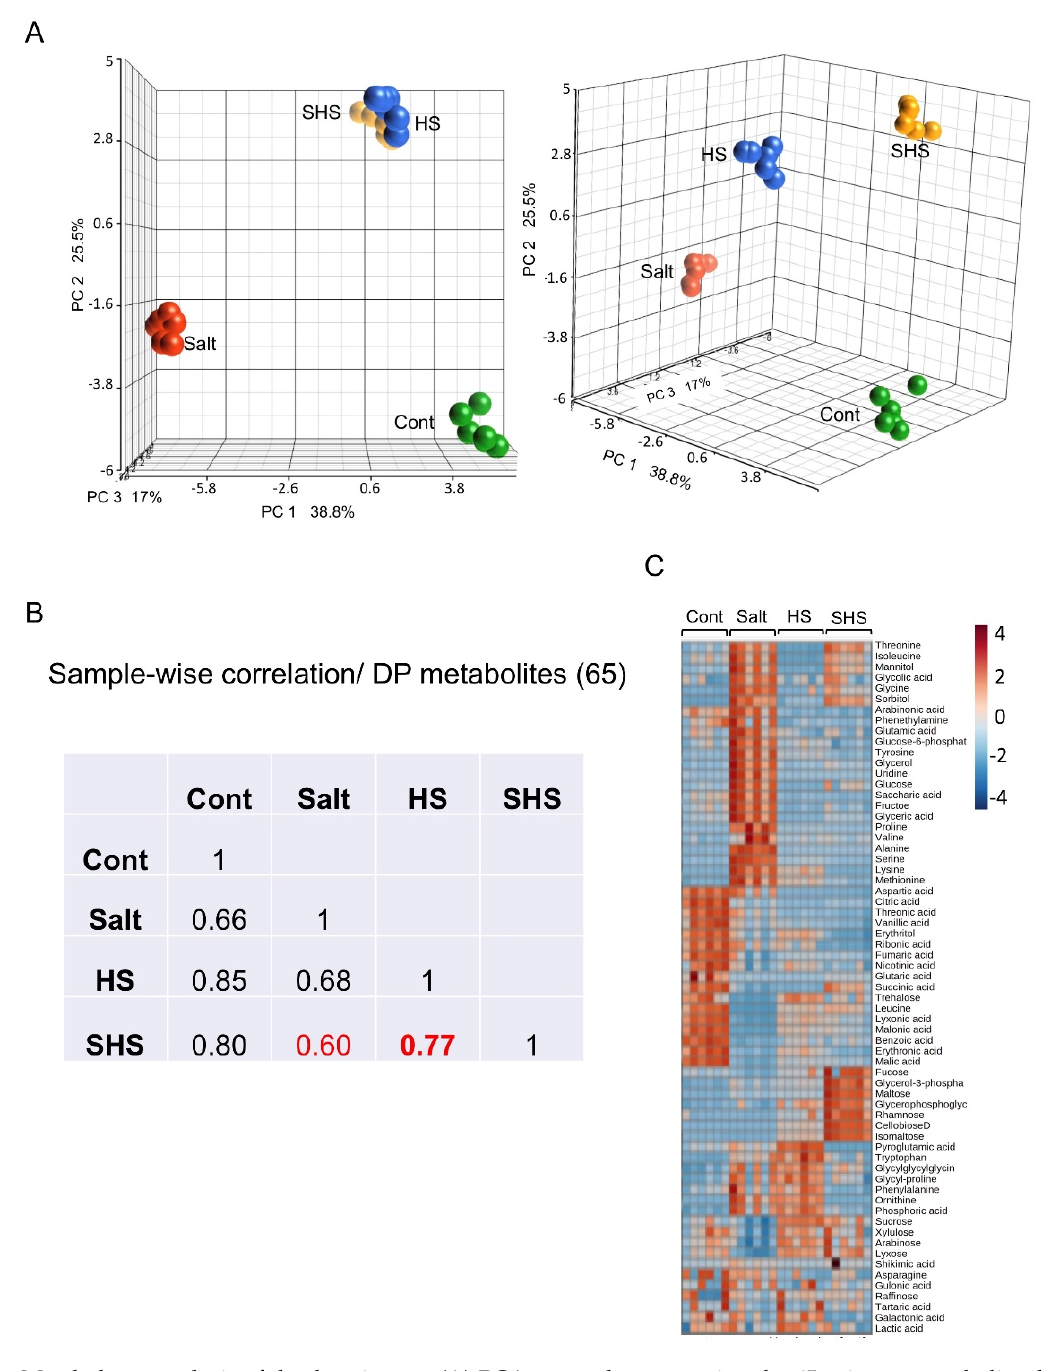
Figure 3. Metabolome analysis of dead pericarps. ( A ) PCA score plot comparing the 65 primary metabolites between pericarps derived from control (Cont), salt (S), heat shock (HS) and SHS-treated plants. ( B ) Sample-wise correlation of DP metabolites showing a relatively high correlation between HS and SHS treatments. ( C ) Hierarchical clustering of differentially present metabolites in dead pericarps after normalization. A comparison of the listed metabolites up and down accumulated in all treatments is shown. Metabolite levels are color-coded with brown and blue representing up and down accumulation, respectively. Each treatment (6 repeats) is represented by six columns.